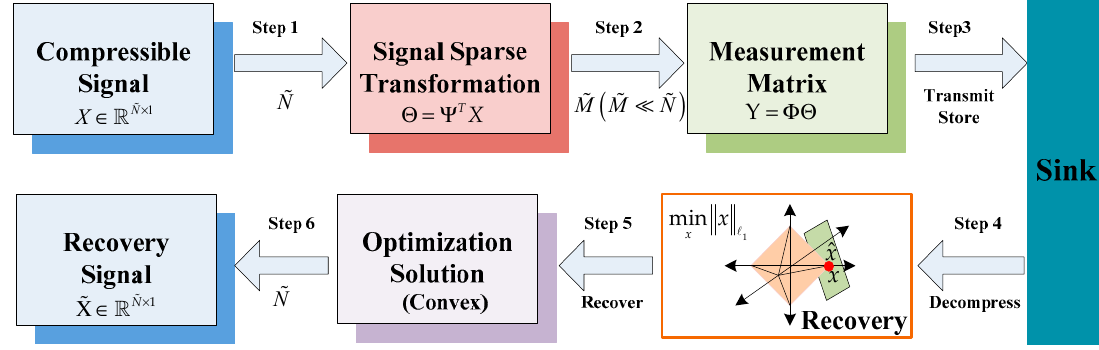
Figure 2. Compressed sensing data fusion model.